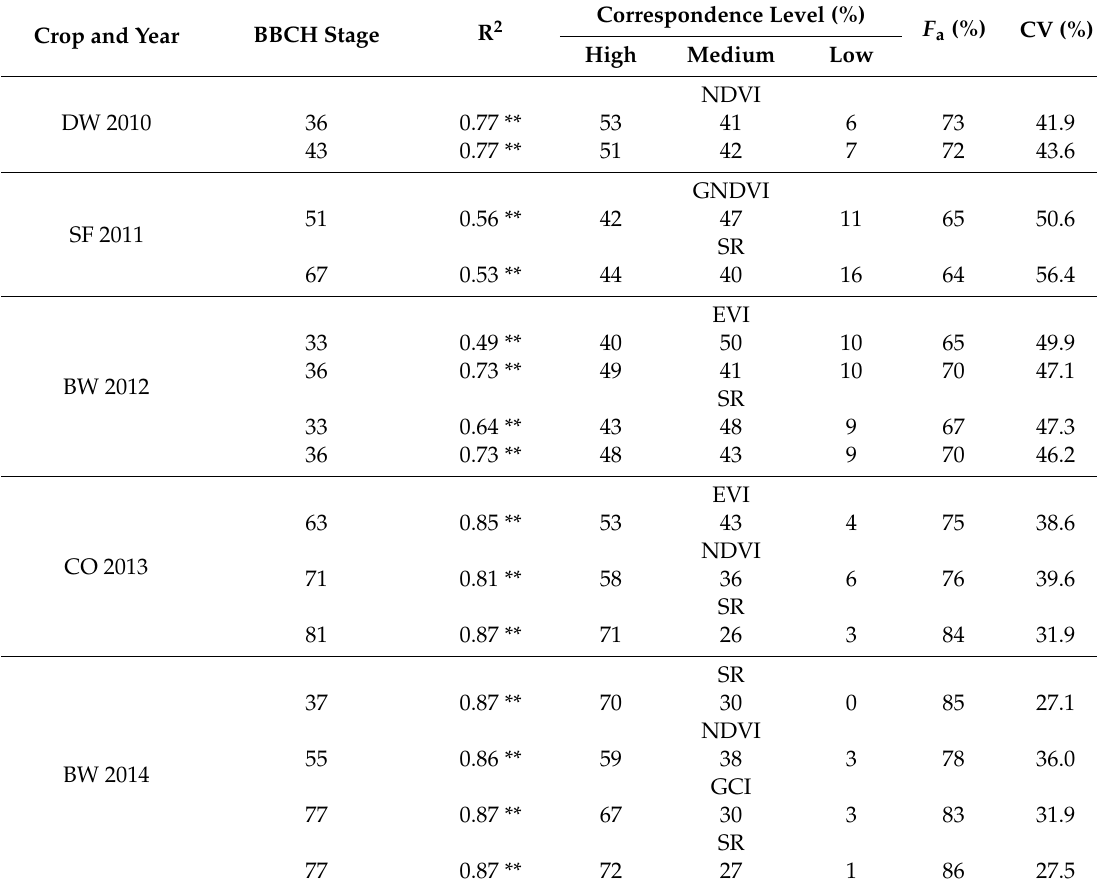
Table 8. R 2 , correspondence levels, final agreements, and respective coe ffi cients of variation between VIs and